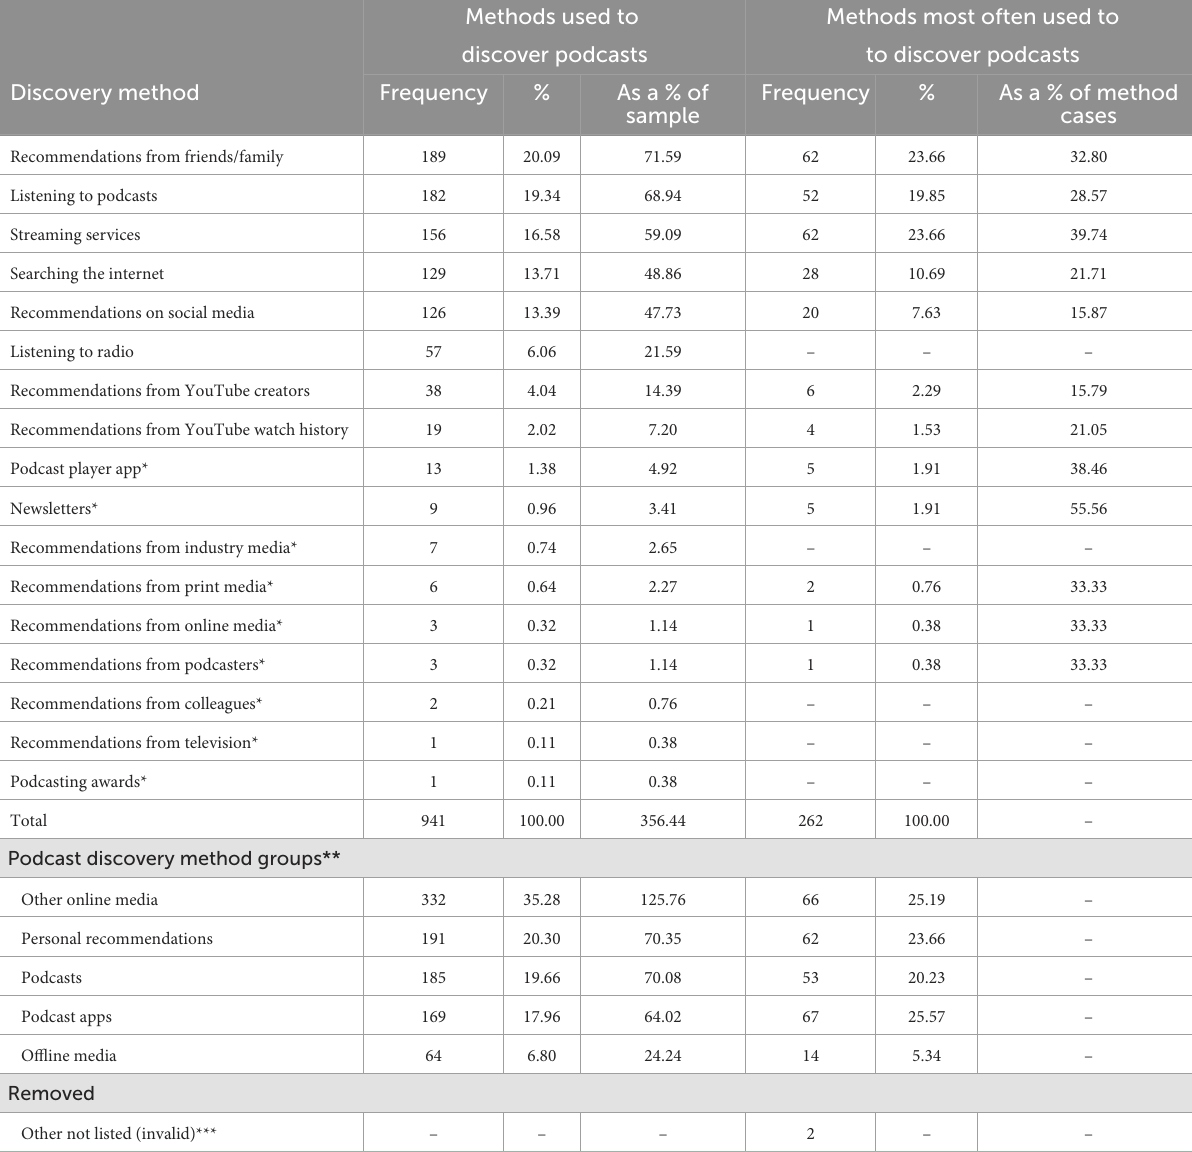
TABLE 8 Methods participants have used ( N = 264) and most often use ( N = 262) to discover